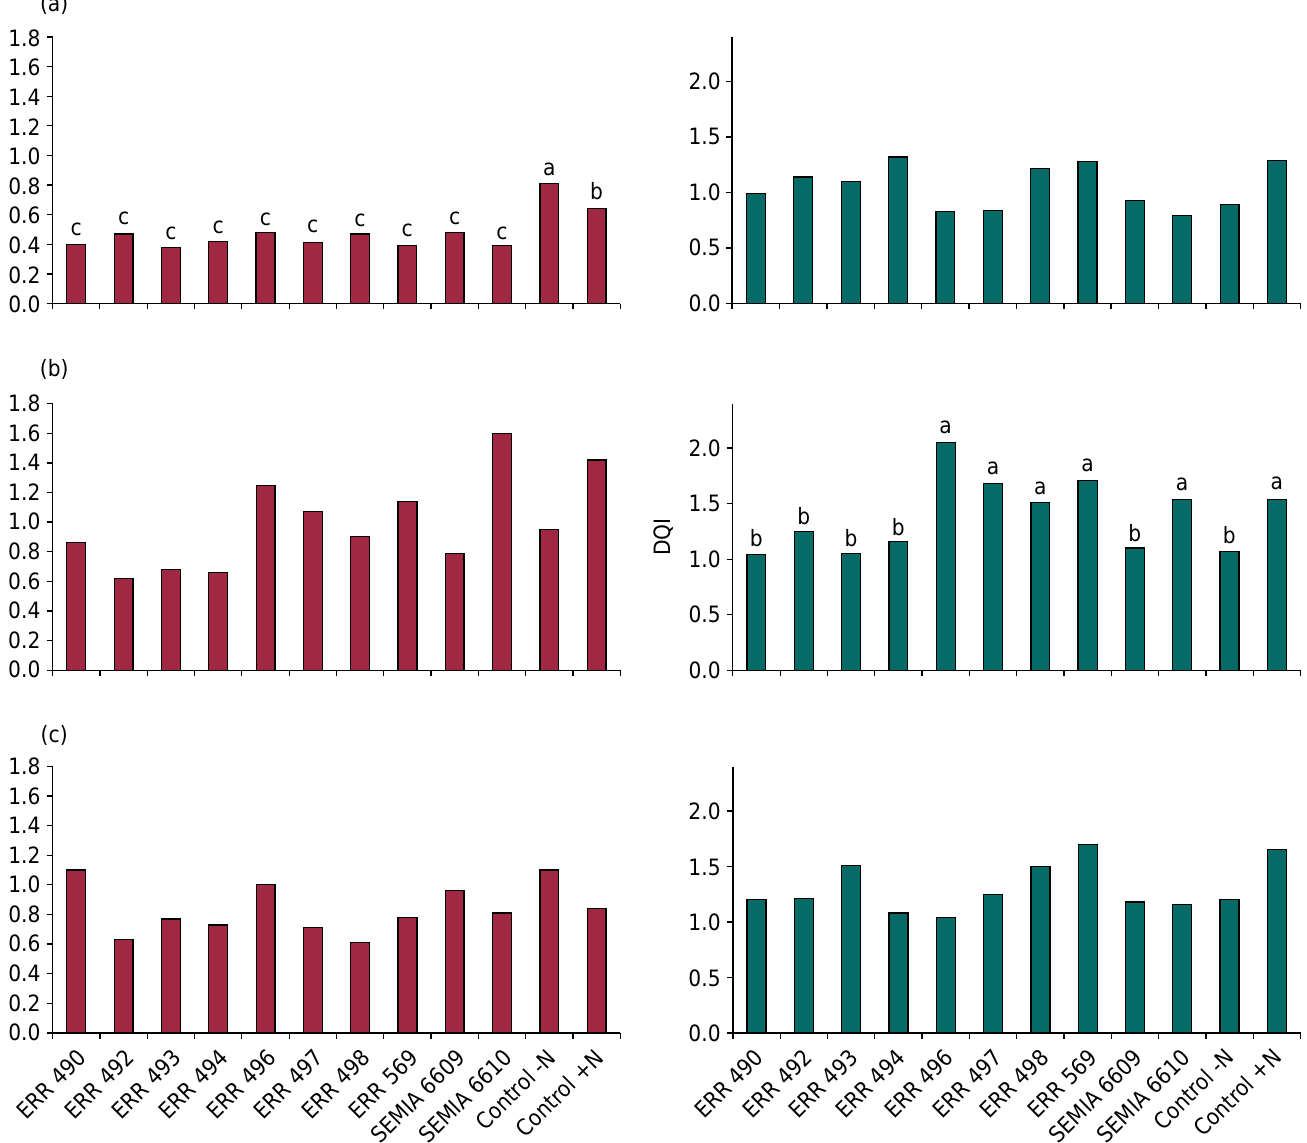
Figure 1. Effects of Bradyrhizobium ingae inoculation on the relationship of root/shoot dry matter ratio (RDM/SDM) and Dickson’s quality index (DQI) of Inga edulis Mart. seedlings. (a) Experiment 1 - sterile substrate in a greenhouse; (b) Experiment 2 - non-sterile soil in a greenhouse; and (c) Experiment 3 - non-sterile substrate in a nursery. Values followed by the same letter were not significantly different according to the Scott-Knott test at 5 %